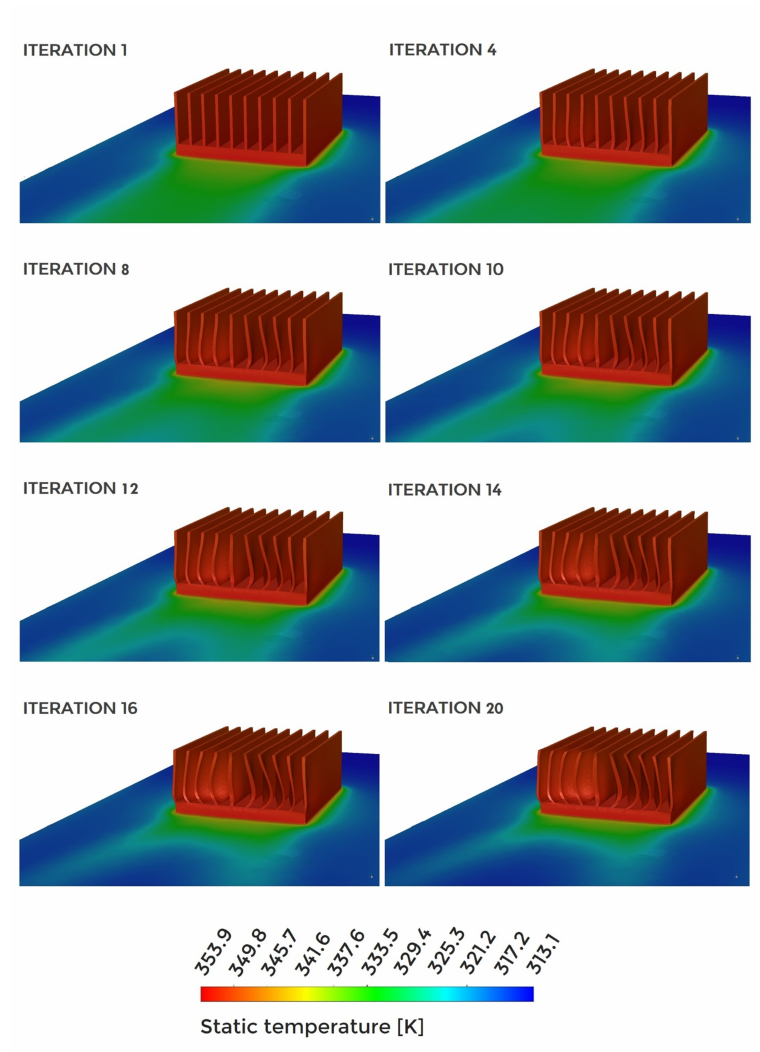
Figure 24. Change in heat sink shape and temperature